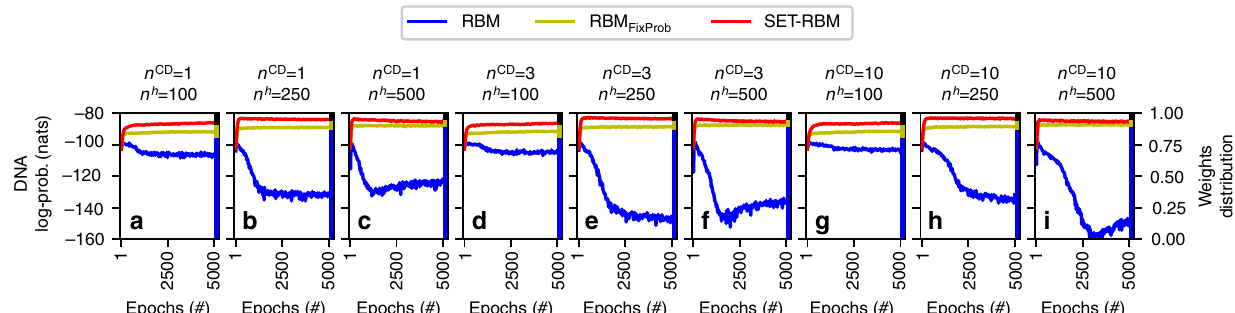
Fig. 2 Experiments with RBM variants on the DNA dataset. For each model studied we have considered three cases for the number of contrastive divergence steps, n CD = 1 ( a – c ), n CD = 3 ( d – f ), and n CD = 10 ( g – i ). Also, we considered three cases for the number of hidden neurons, n h = 100 ( a , d , g ), n h = 250 ( b , e , h ), and n h = 500 ( c , f , i ). In each panel, the x axes show the training epochs; the left y axes show the average log-probabilities computed on the test data with AIS 33 ; and the right y axes (the stacked bar on the right side of the panels) re fl ect the fraction given by the n W of each model over the sum of the n W of all three models. Overall, SET-RBM outperforms the other two models in most of the cases. Also, it is interesting to see that SET-RBM and RBM FixProb are much more stable and do not present the over- fi tting problems of RBM